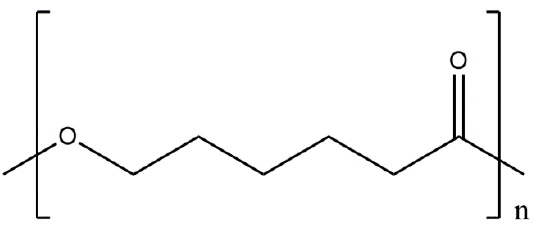
Figure 17. Schematic representation of polycaprolactone’s chemical structure.